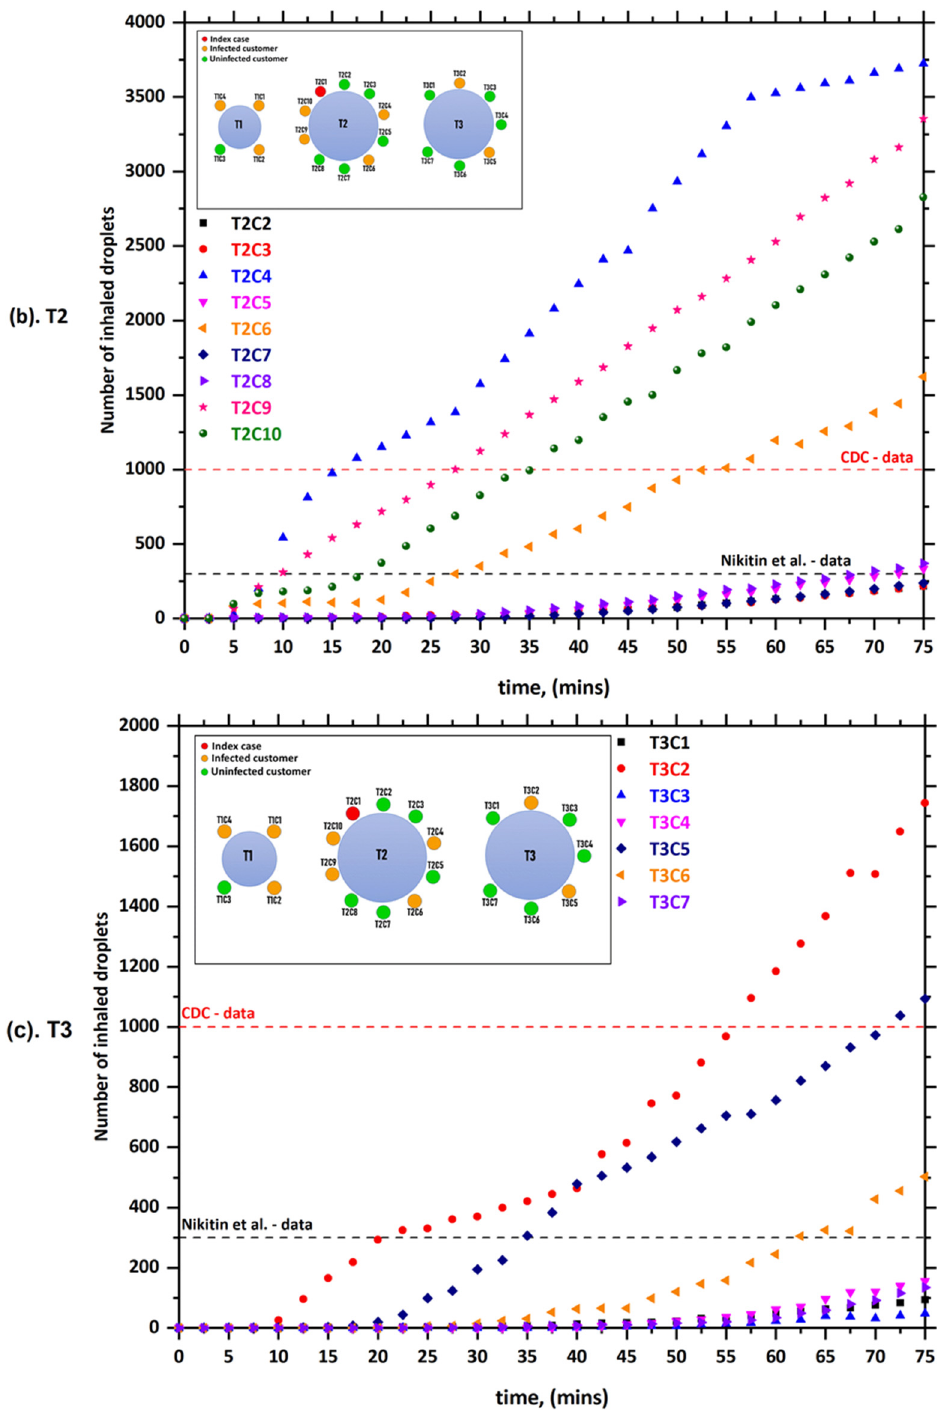
Figure 3. The number of inhaled droplets/particles by healthy individuals in a restaurant setting— case-1; ( a ) T1: Table 1, ( b ) T2: Table 2, and ( c ) T3: Table 3 [35]. 1; ( a ) T1: table 1, ( b ) T2: table 2, and ( c ) T3: table 3